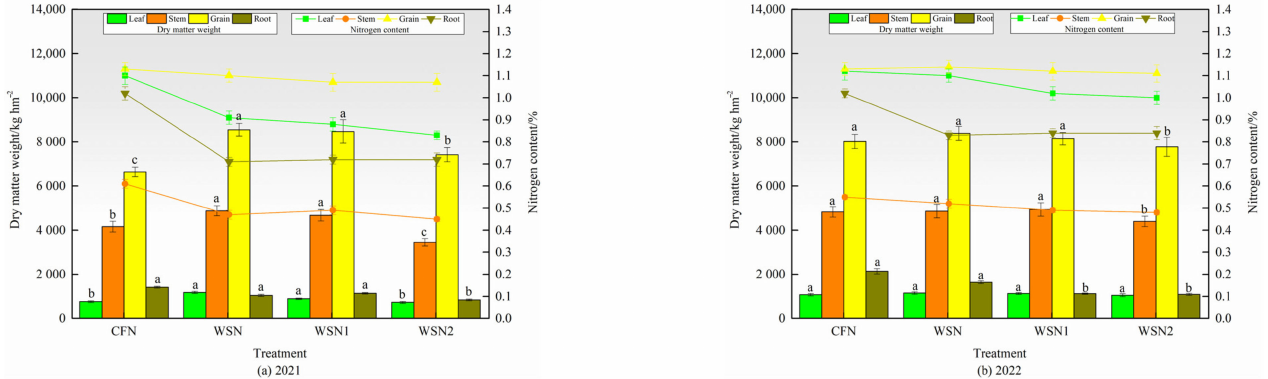
Figure 5. Dry matter weights and the nitrogen contents of the plants in ( a ) 2021 and ( b ) 2022. Bars represent means SE. Different letters indicate significant differences ( p < 0.05) between different